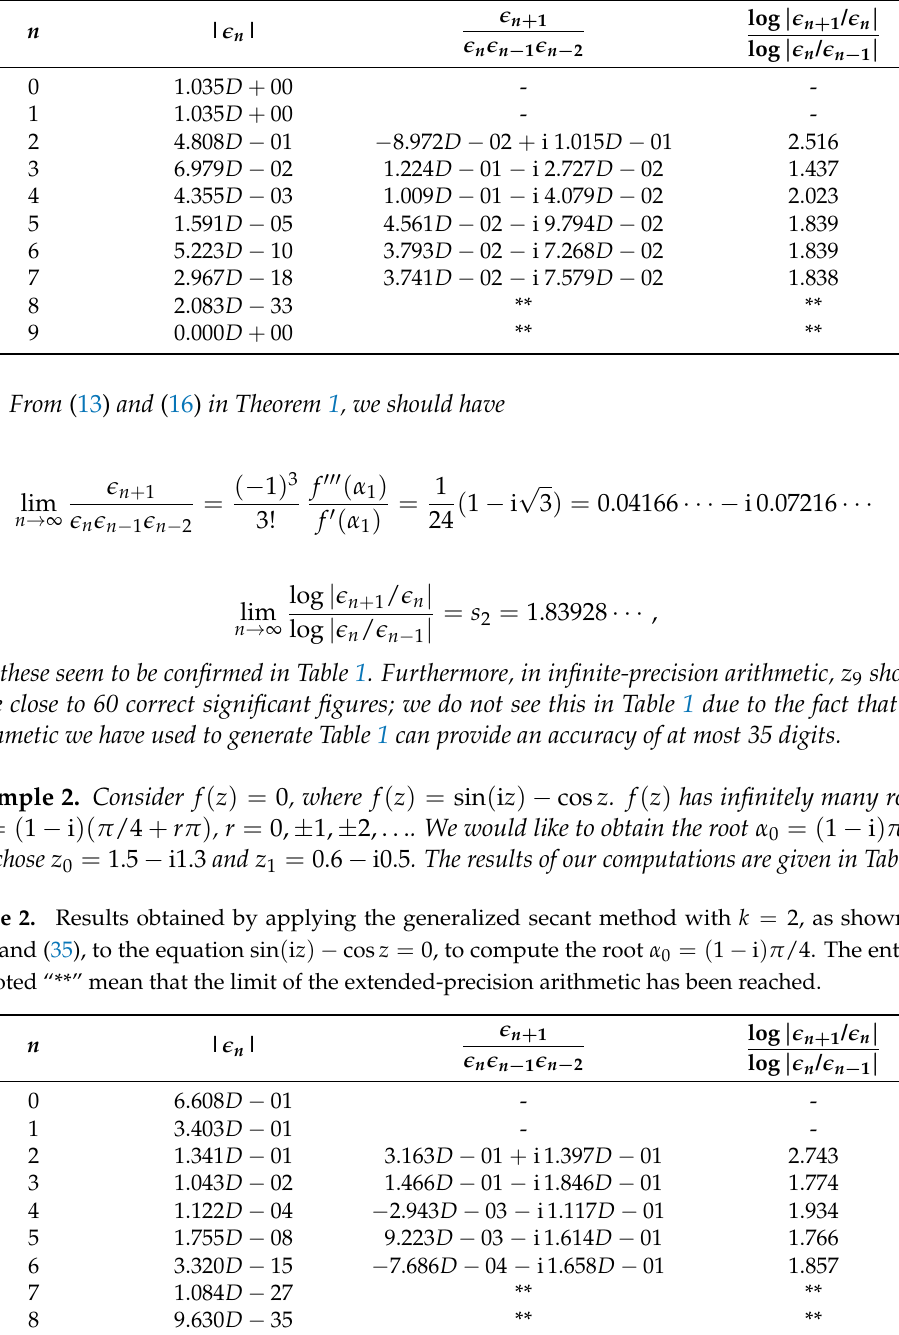
√ 3. The entries denoted “**” (cid:101) n + 1 (cid:101) n (cid:101) n − 1 (cid:101) n − 2